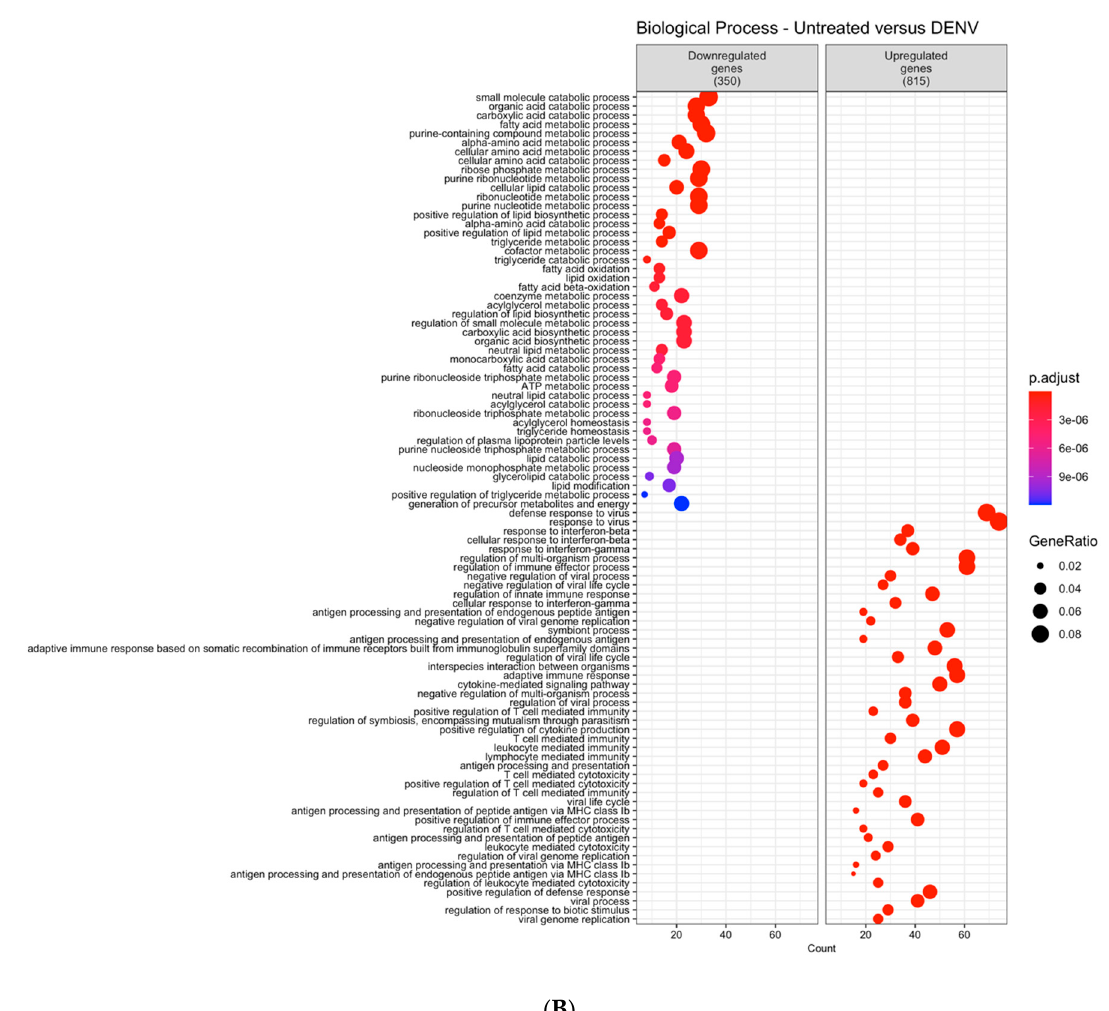
Figure 1. Dot plot of hierarchical summaries of gene ontology (GO) terms enriched in differentially expressed genes in AML-12 hepatocytes treatment with ( A ) APAP or ( B ) infection by DENV-2. Data were obtained from the analysis of the GO terms that were significantly enriched within the biological process categories (p.adjust < 0.05) among differentially expressed genes (DEGs) from each comparison. Dots represent the enriched GO terms after summarization with the REVIGO tool. The color of the dots represents the p-adjust values following Benjamini–Hochberg (BH) significance testing. The position of the dots in the x-axis (Count) is related to the amount of DEGs associated with the GO term. The size of the dots (GeneRatio) represents the number of DEGs related to the number of genes associated with a GO term in the Mus musculus genome.